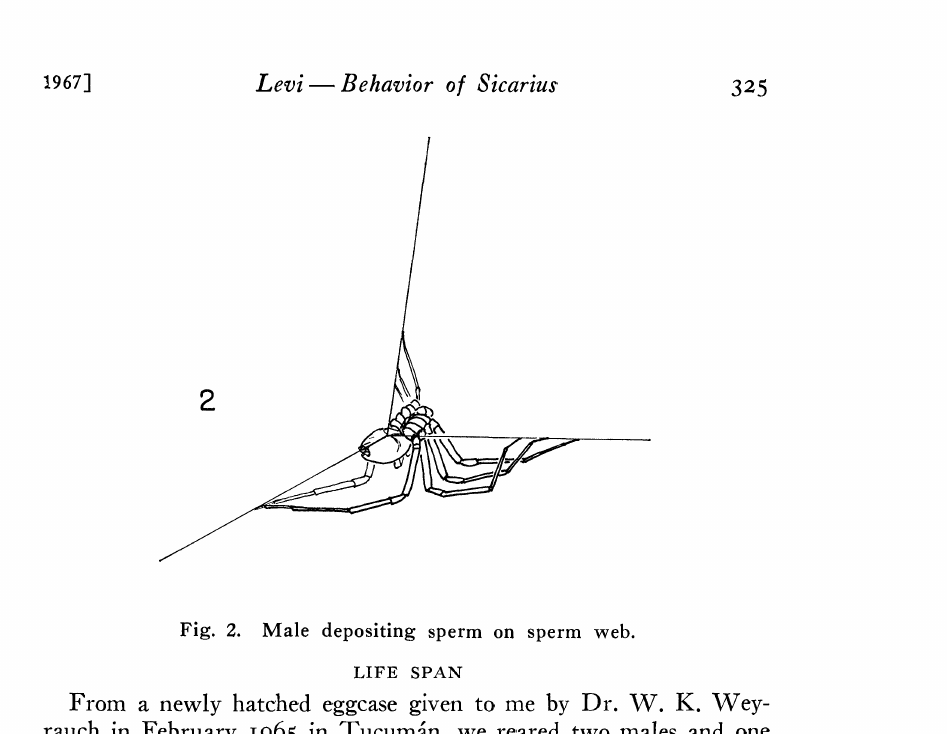
Fig. 2. Male depositing sperm on sperm web. LIFE